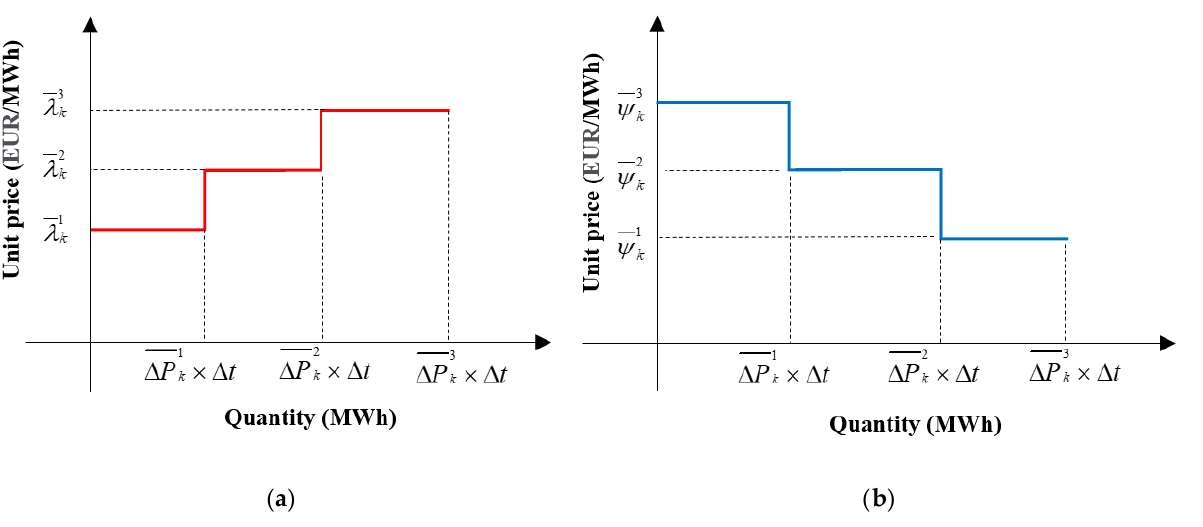
Figure 2. ( a ) Upward and ( b ) downward bids submitted by aggregator to DSO for corresponding time